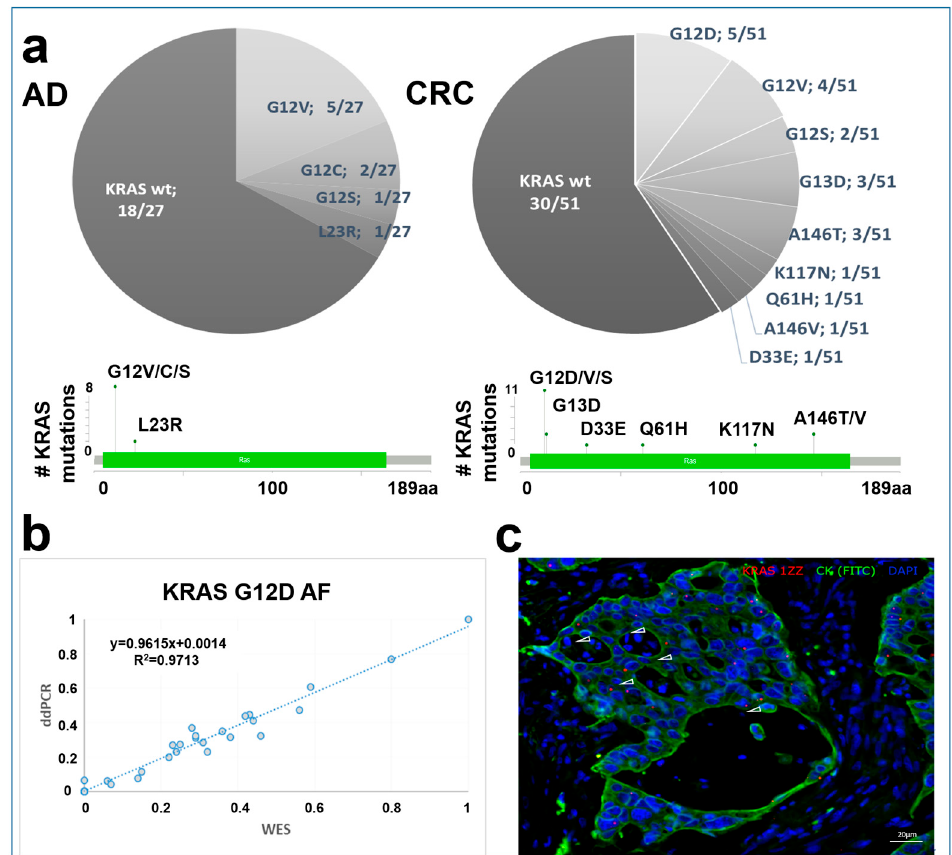
Figure 5. KRAS variant distribution in AD and CRC samples. ( a ) KRAS variant distribution in AD and CRC groups on pie charts and lollipop plots. ( b ) KRAS G12D variant validation using the ddPCR method. The X -axis represents WES, while the Y -axis shows ddPCR allele frequency (AF) data. ( c ) Representative image of in situ hybridization of KRAS G12D mutation in CRC samples. Combined fluorescent image of KRAS G12D probes (red, white arrowheads) in CK-positive (green) colon epithelial cells. Nuclei were stained with DAPI.